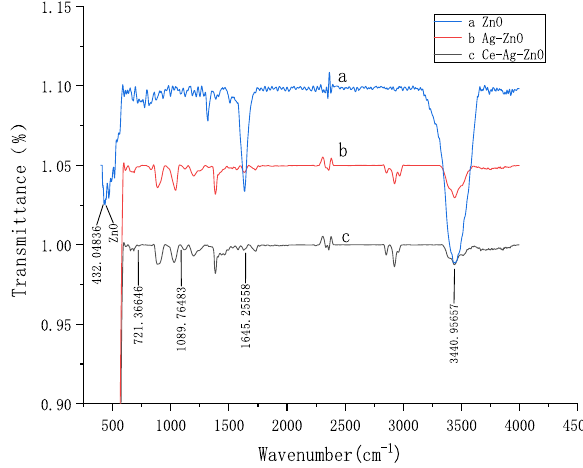
Figure 1: FT - IR of ZnO, Ag - ZnO, and Ce/Ag/ZnO